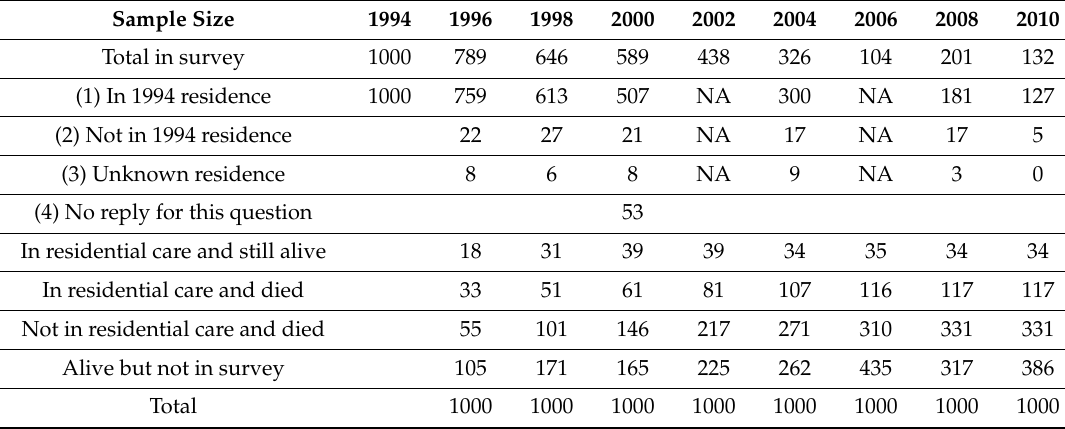
Table 1. Participants across waves